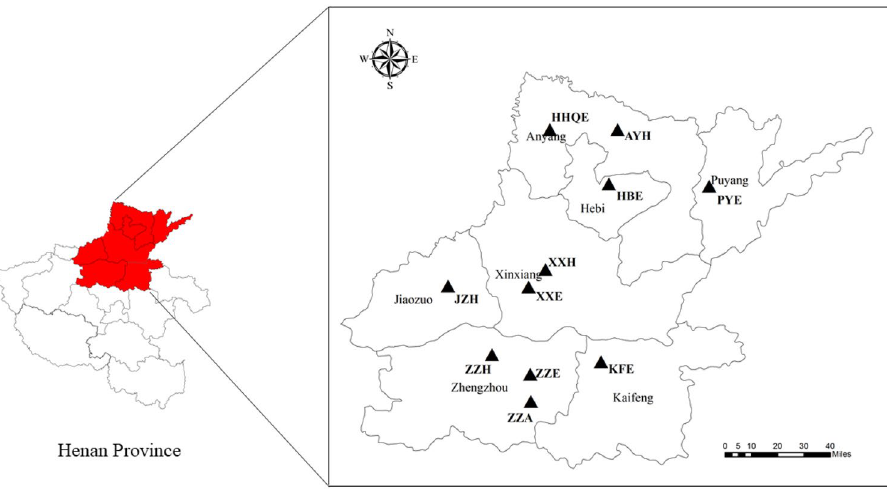
Figure 1. Location of 11 industrial parks in Henan Province. Map was created in ArcGIS Desktop v. 10.2 software. (http:// www. esri. com/ softw are/ arcgis/ arcgis- for- deskt op/ free- trial).